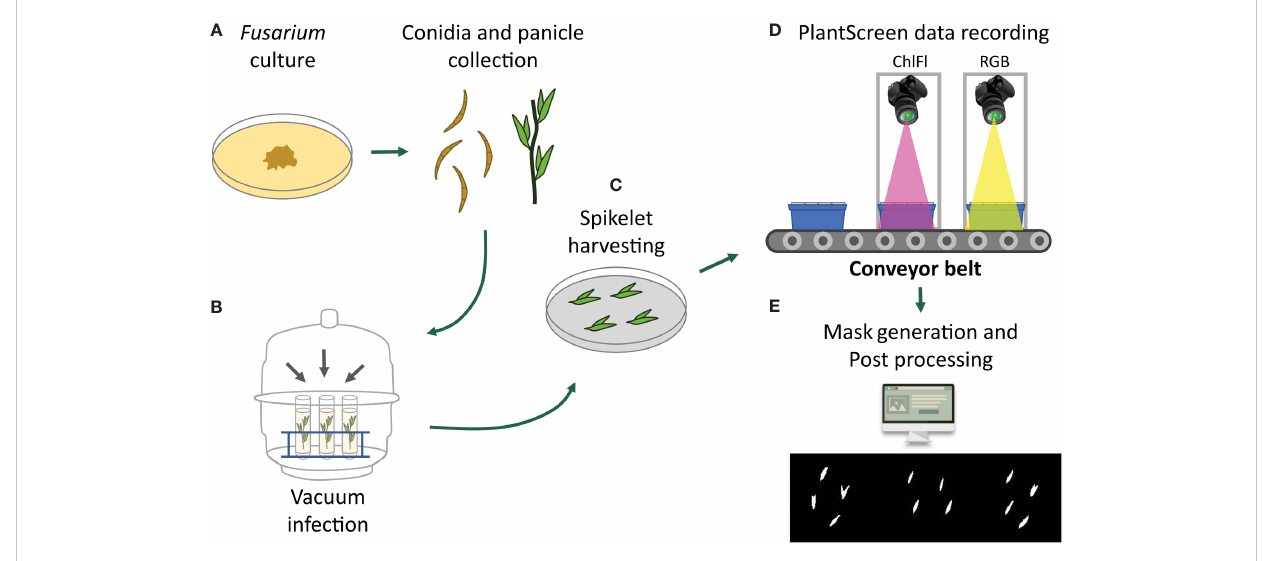
FIGURE 1 Collage of the experimental work fl ow. (A) Fusarium cultures were prepared for conidia collection at the same time when the oat panicles were getting ready for inoculation. (B) Vacuum inoculation of panicles was performed within an exicator. (C) Dissected spikelets were placed on agar plates in exactly de fi ned coordinates for automated detection by FIJI. (D) Imaging of spikelets on the petri plates placed on the blue imaging trays by RGB or ChlFl imaging. (E) Detection of mycelia growth symptoms by visible observations on RGB images and by ChlFl pixel data extraction for recording disease progression and